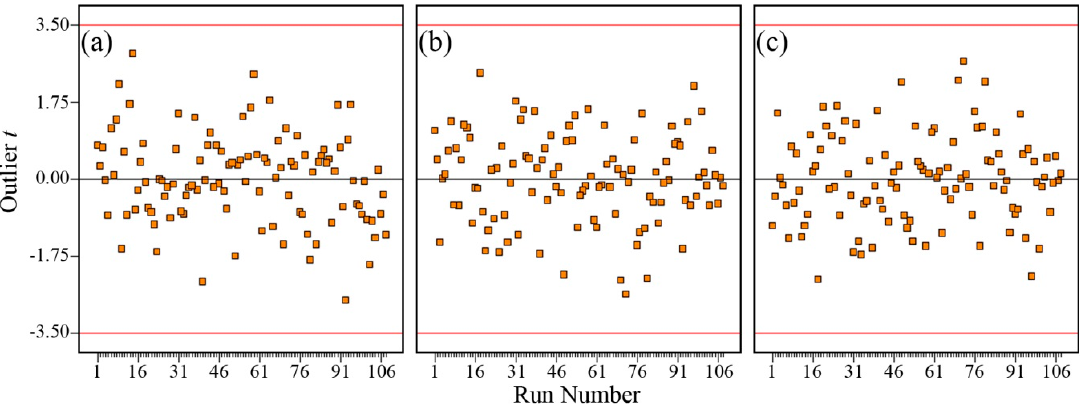
Figure 9. Outlier t plot for ( a ) σ (×10 − 2 S·cm − 1 ); ( b ) log 10 [ D (×10 − 6 cm 2 ·s − 1 )]; and ( c ) log 10 [ n (×10 18 cm − 3 )].